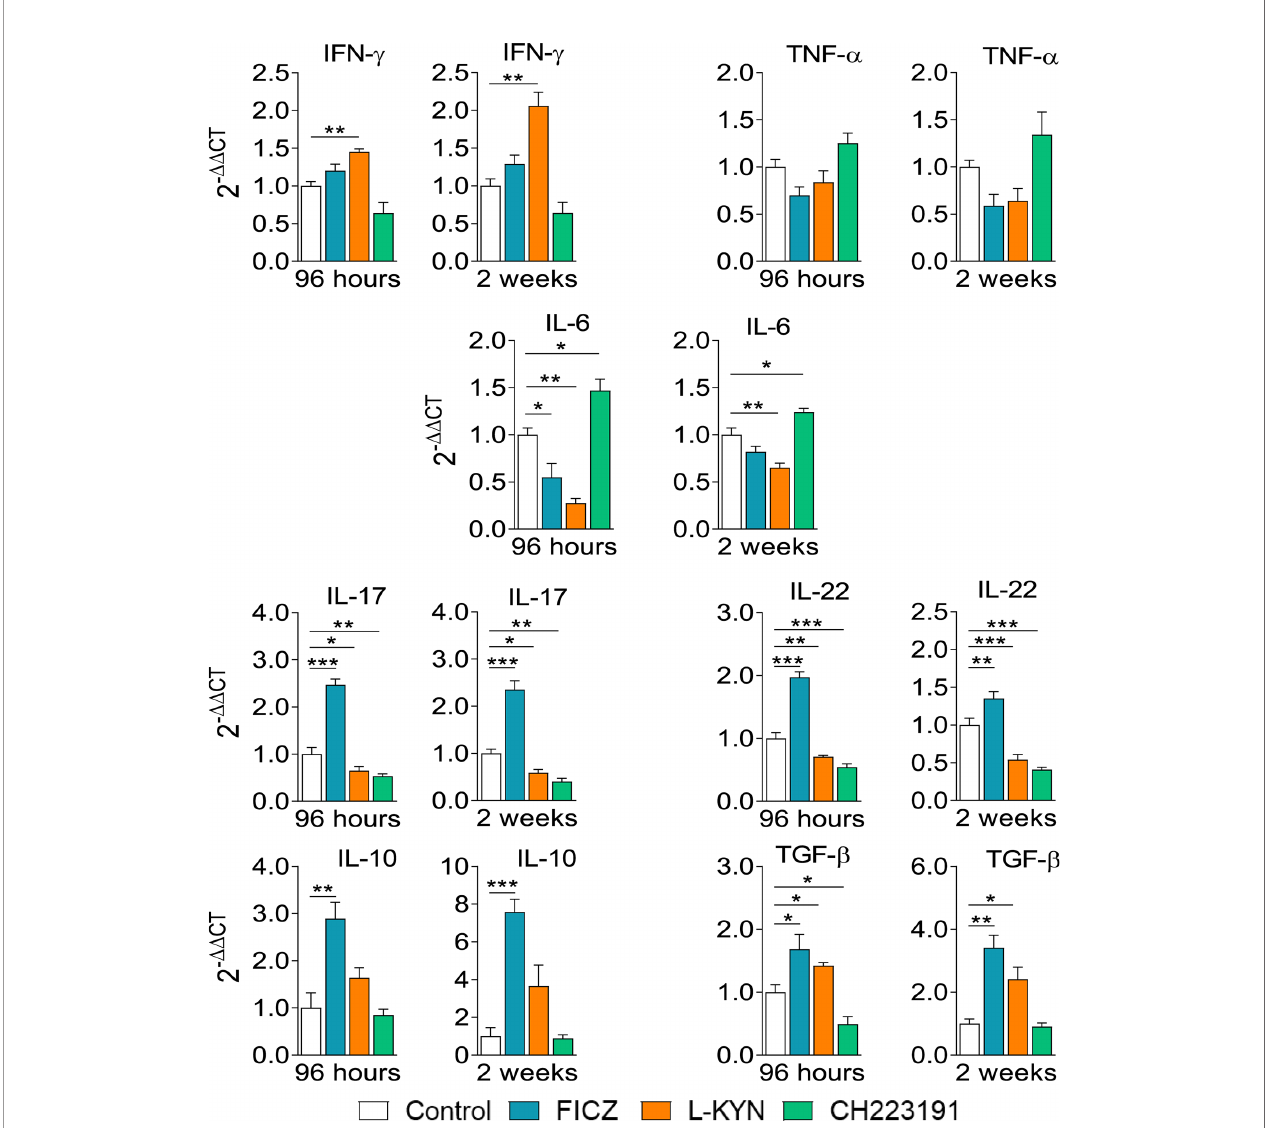
FIGURE 6 | Treatment with AhR ligands alters mRNA expression for pro- and anti-in fl ammatory cytokines in the lungs of P. brasiliensis infected mice. C57BL/6 mice (n = 5) were infected with 1 x 10 6 P. brasiliensis yeasts and treated with FICZ, L-Kyn, CH223191 as previously described. Control mice were treated with PBS. The animals were sacri fi ced 96 hours and 2 weeks after infection, their lungs removed, macerated, and the RNA obtained analyzed by RT-PCR as described in M&M. The experiment was repeated twice, and data are expressed as M ± SD. P values < 0.05 were considered signi fi cant (* p < 0.05; ** p < 0.005 and *** p <